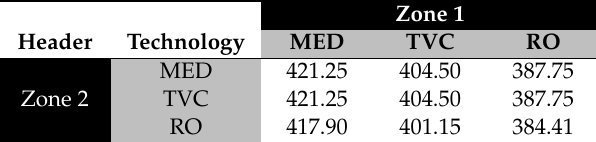
Table A3. Price of electricity ( € / MWh).